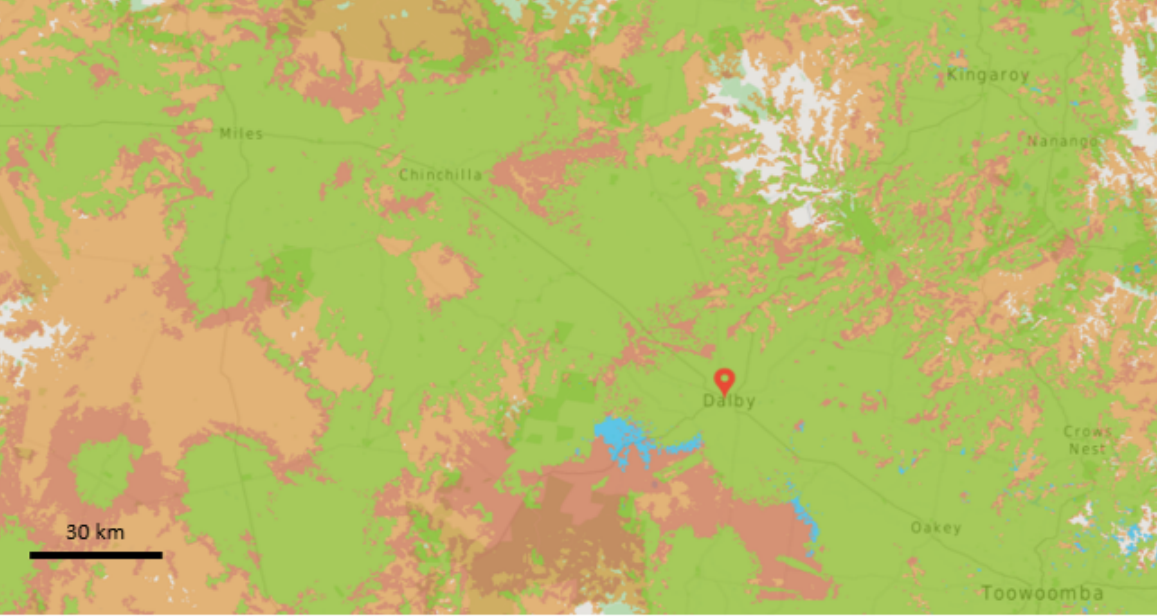
Figure 6. Network coverage for the field testing site in Dalby, Queensland (green, good 4G reception; blue, slower 4G reception; red, 3G reception only; orange, external antenna required for reception). Image adapted from